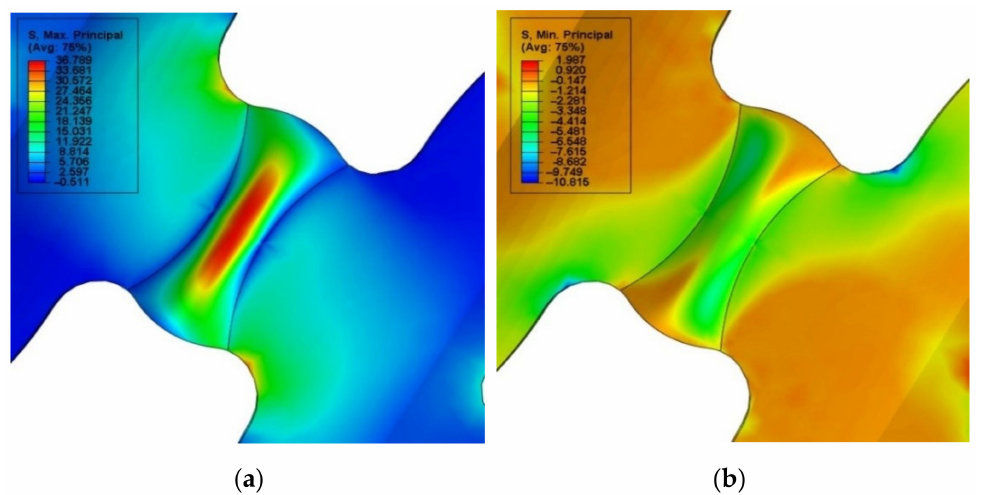
Figure 6. Major ( a ) and minor ( b ) principal stress variation at yielding for the tests at 30 ◦